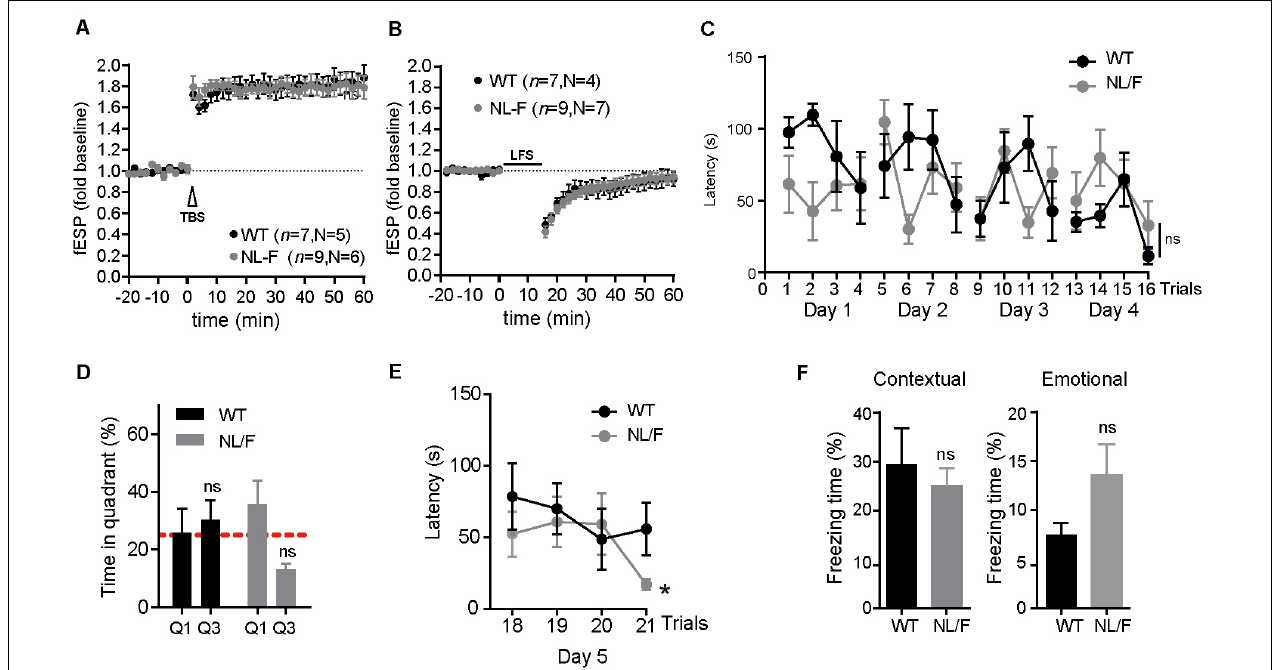
FIGURE 2 | Synaptic plasticity, learning and memory are not affected in old APP NL/F mice. (A,B) LTP induction by TBS (A) and LTD by LFS (B) on hippocampal slices of WT and hAPP NL/F mice. The number n of slices used of N animals of each genotype is defined. The graphs show the mean ± SEM, two-way Student t, (ns: not significant, vs. WT). (C) Graphic representation of the latency time to the platform in APP NL/F and WT mice during the learning phase of the Morris water maze. Statistical significance was analyzed by T test of repeated samples. (D) Analysis of the percentage of swimming time in the target quadrant (Q1) and the opposite quadrant (Q3) on the day of the test ( n = 5 WT mice and 7 NL/F mice). The graphs show the mean ± SEM. Statistical significance was analyzed by two-way T test. (ns: not significant vs. WT). (E) Reversal learning curve, in which the submerged platform has changed position ( n = 5 WT mice and 7 NL/F mice). The graphs show the mean ± SEM. Statistical significance was analyzed by two-way T test. (ns: not significant) (* p < 0.05, vs. WT). (F) Graphic representation of the freezing time percentage of hAPP NL/F and WT mice during the exposure to the context related to the aversive stimulus (left) or to the tone (right) ( n = 5 WT mice and 8 NL/F mice). The mean ± SEM is represented. Statistical significance was analyzed by t test of two ways (ns: not significant, vs.